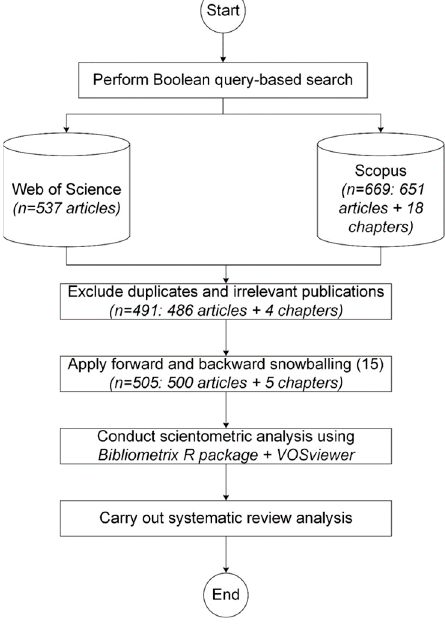
Figure 1. Framework of the developed research methodology for relevant literature in the CBD_NDT domain.